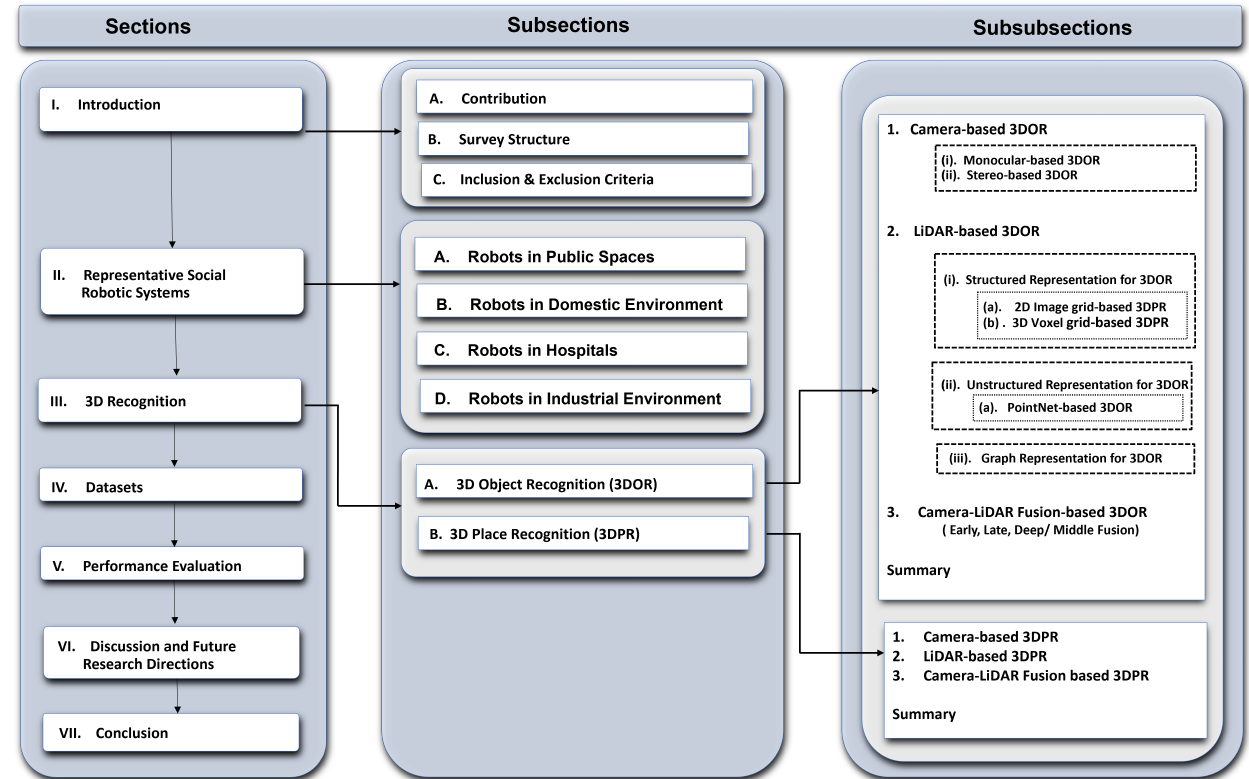
Figure 1. The overall structure of the survey that shows all the topics discussed in each